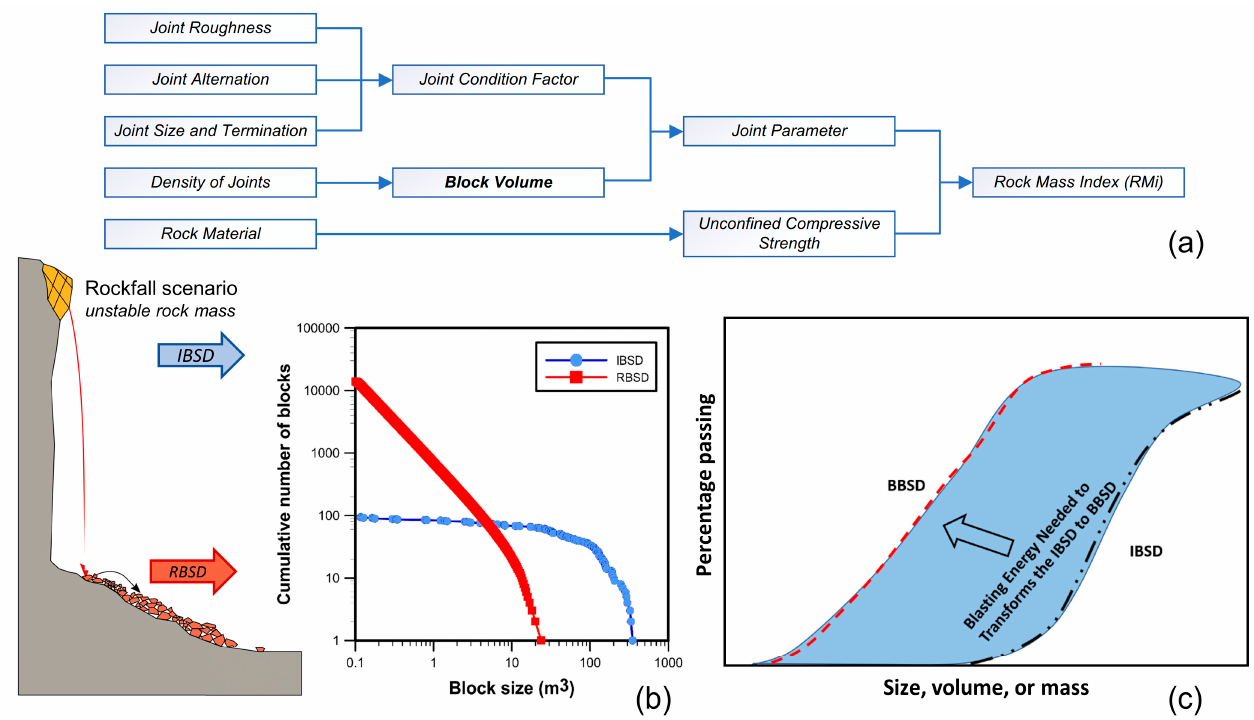
Figure 15. ( a ) The main inherent rock mass parameters in the RMi according to [75]. ( b ) A schematic view of the RFFM. The change in block volume distribution by fragmentation. The IBSD results in an increase of the number of blocks by fragmentation (RBSD) modified from Ruiz-Carulla and Corominas [79]. ( c ) Schematic view of the energy-block-transition model modified from Salmi and Sellers